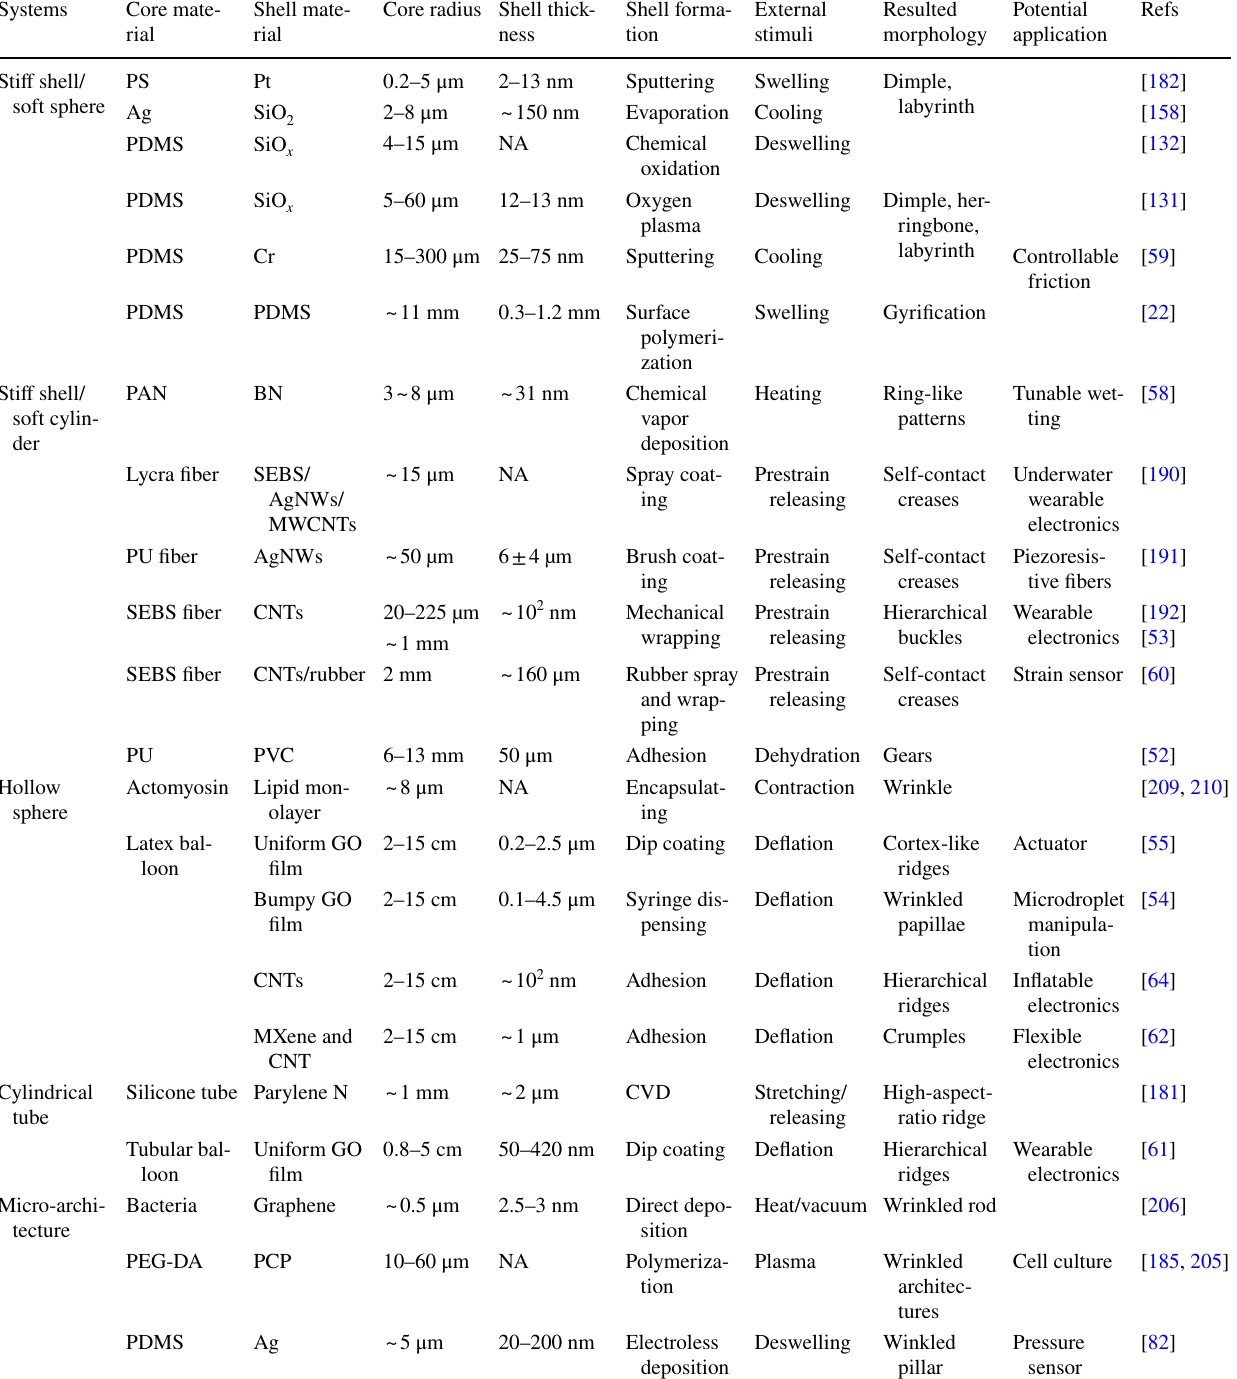
Table 2 Main approaches and parameters for the fabrication of diverse wrinkling patterns on various curved substrates and their applications